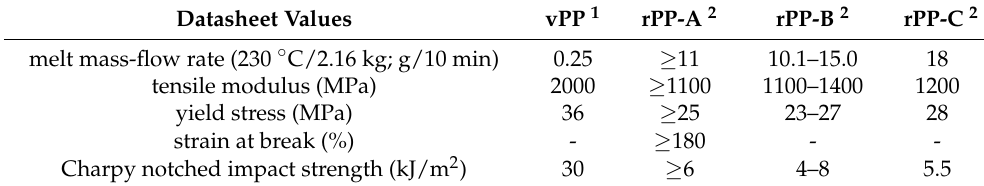
Table 1. Datasheet values of all used materials. Datasheet